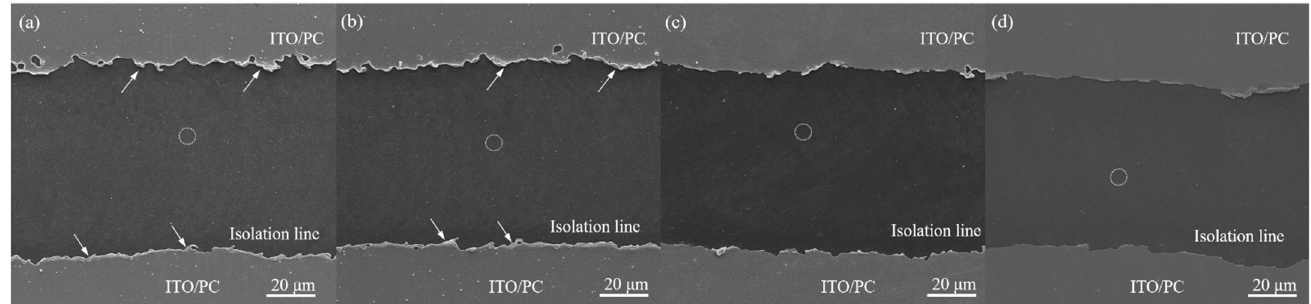
Figure 4. Surface morphologies of the isolation line ablated by 5 W with different pulse repetition rates: ( a ) 70, ( b ) 80, ( c ) 90, and ( d ) 100 kHz.